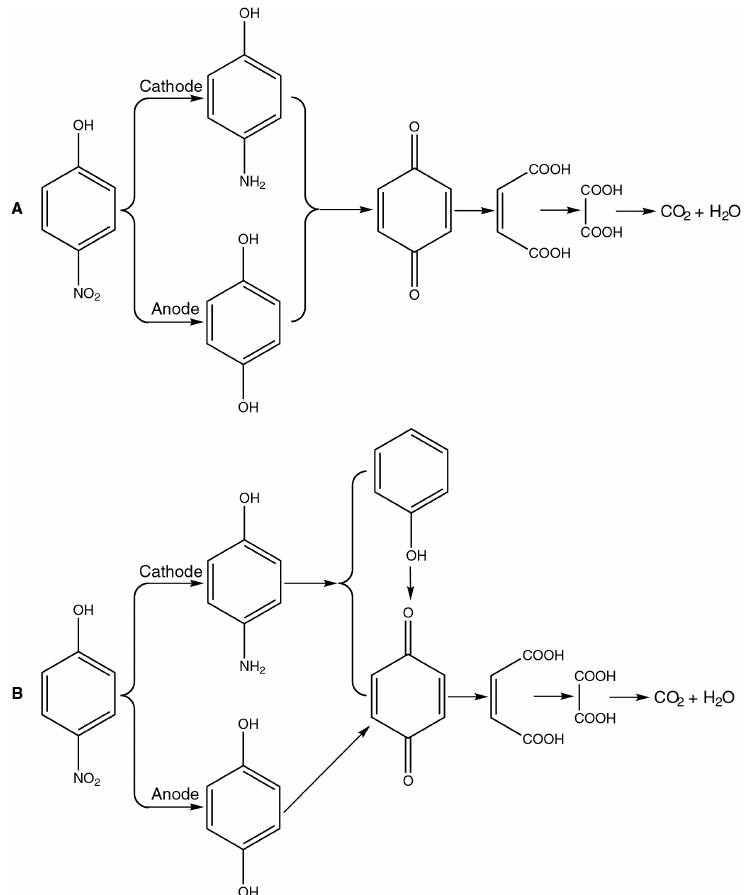
Figure 4: Degradation pathways of p -NP at (A) boron-doped diamond and (B) platinum electrodes (Zhang et al. 2013b; © Copyright Elsevier